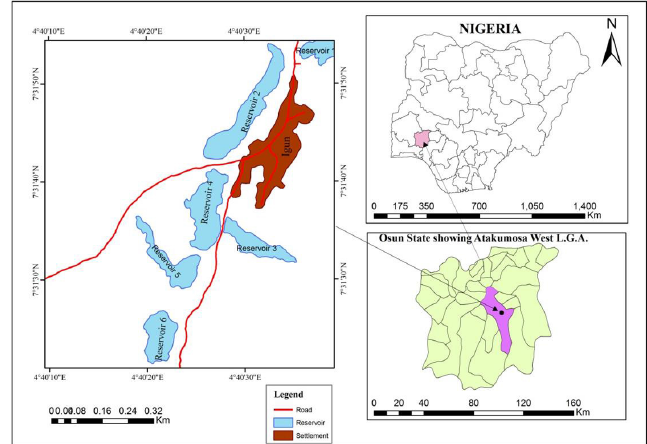
Fig. 1. Map of Nigeria showing abandoned gold mine reservoirs at Igun